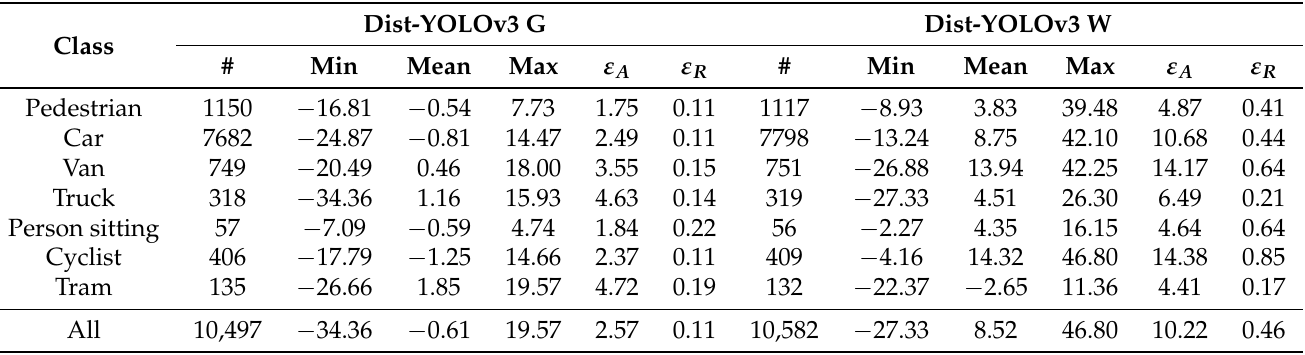
Table 2. Measurement of distance error in meters for Dist-YOLOv3 G/W. The values in columns Min, Mean, and Max, ε A are expressed in meters. The value of column ε R is relative, where ε R = 1 equals to